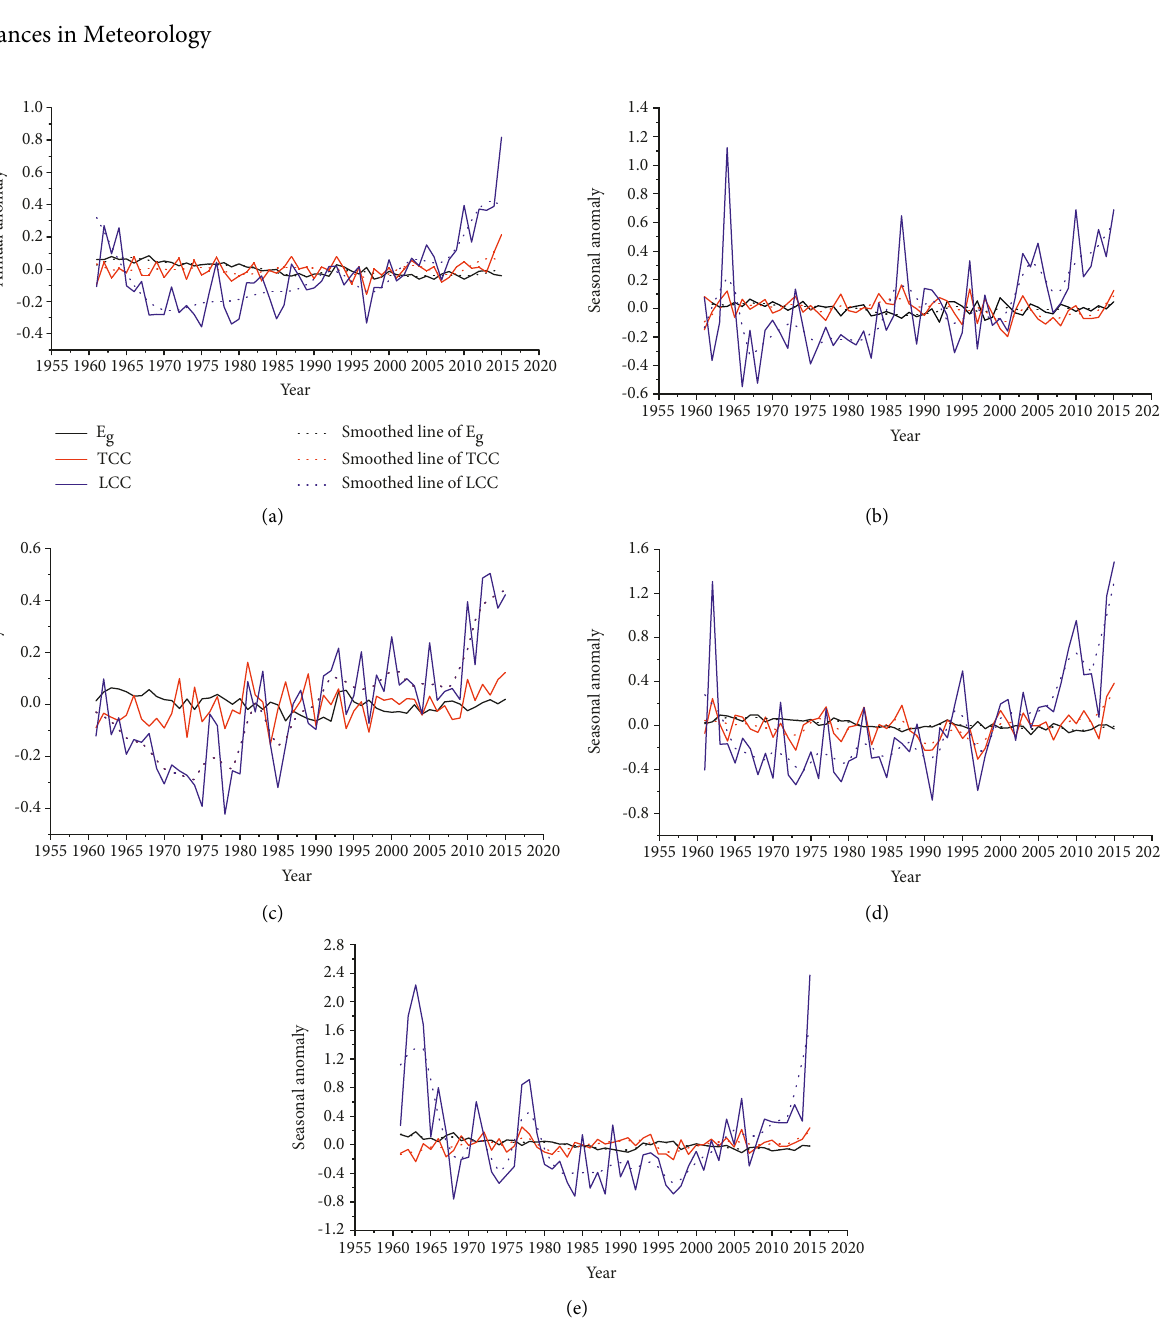
g (black solid lines), TCC (red solid lines), and LCC (blue solid lines) smoothed